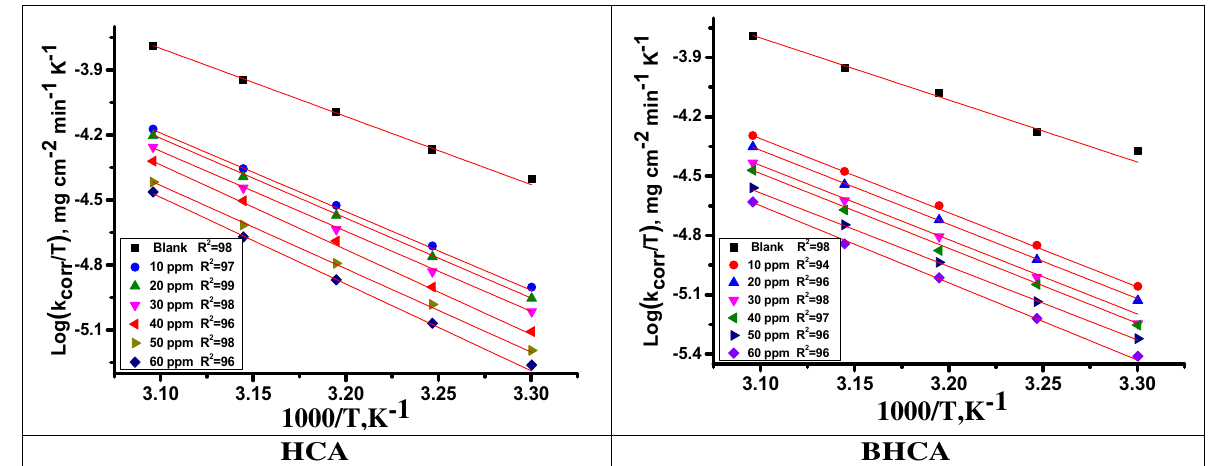
Figure 6. Corrosion of CS in 1 M HCl in the absence and presence of altered concentrations of HCA &BHCA plotted as (log k corr /T) vs. 1000/T.